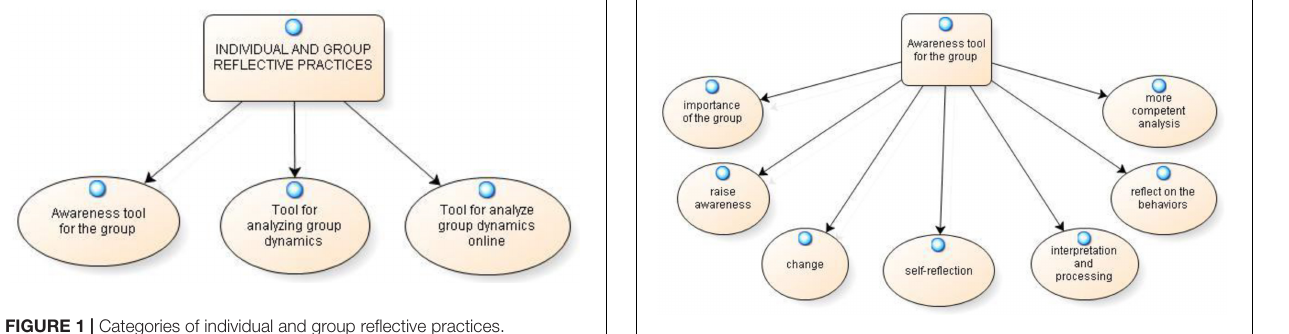
FIGURE 2 | Awareness tool for the